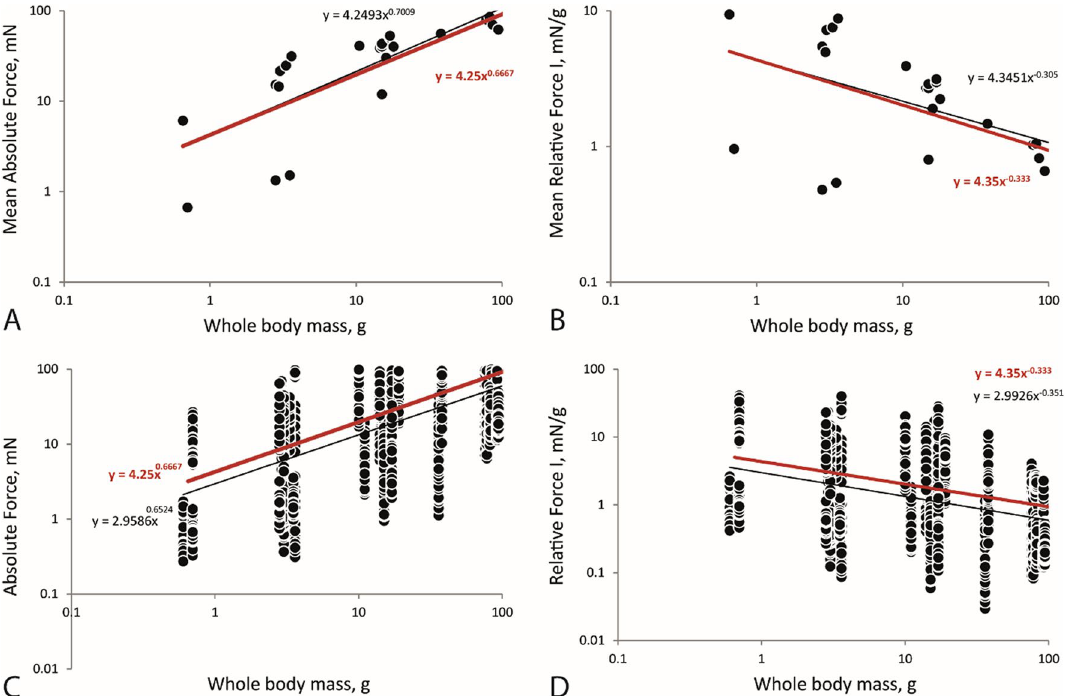
Figure 5. Linear regression, displayed on logarithmic axes, with trend lines (black = real trend line; red = calculated trend line for the factors 4.25 and 4.35), regardless of the direction. ( A ) Mean Absolute Force versus mean whole body mass. A radular force quotient, AFQ = mean Absolute Force/Bodymass 0.67 , of 4.25 was determined. ( B ) Mean Relative Force I versus mean whole body mass. A Relative Force Quotient, RFQ = mean Relative Force I/Bodymass −0.33 , of 4.35 was determined. ( C ) Variance of Absolute Force versus mean whole body mass. ( D ) Variance of Relative Force I versus mean whole body mass. For C and D a force quotient of 3.00 was